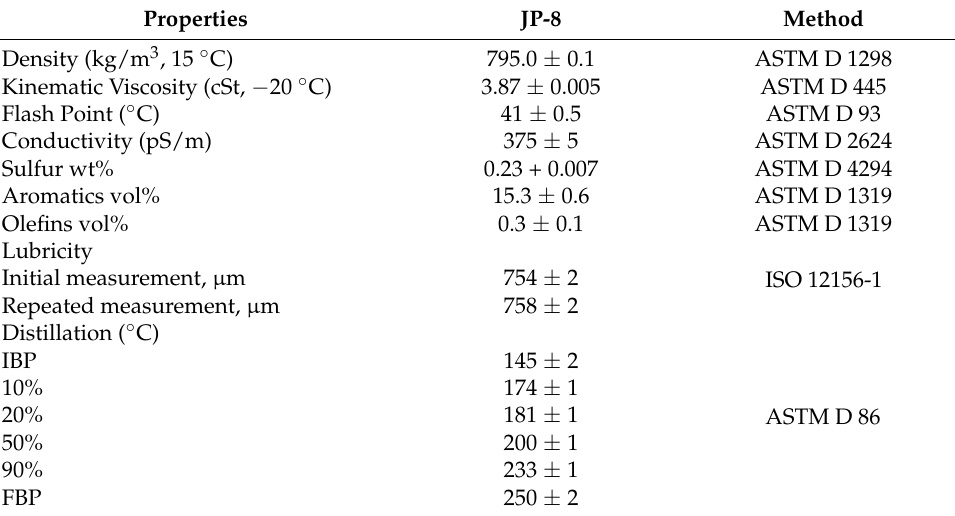
Table 3. Main properties of aviation fuel with measurements uncertainties.